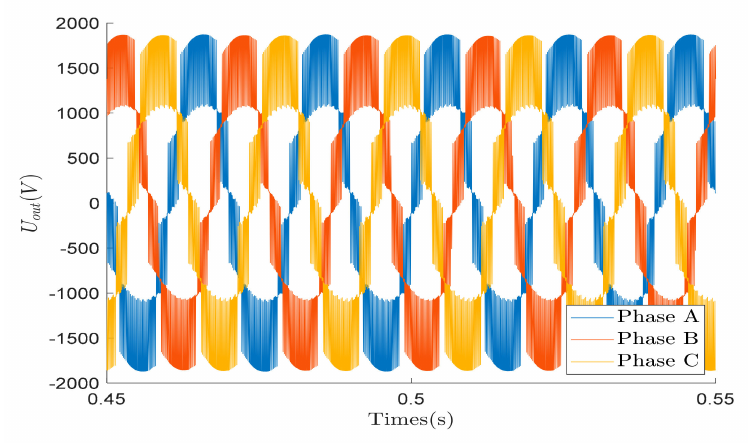
Figure 8. Three-phase output voltage in normal state.